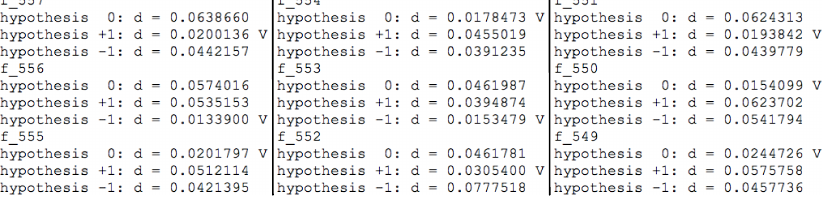
Figure 9: The Result of the OTA